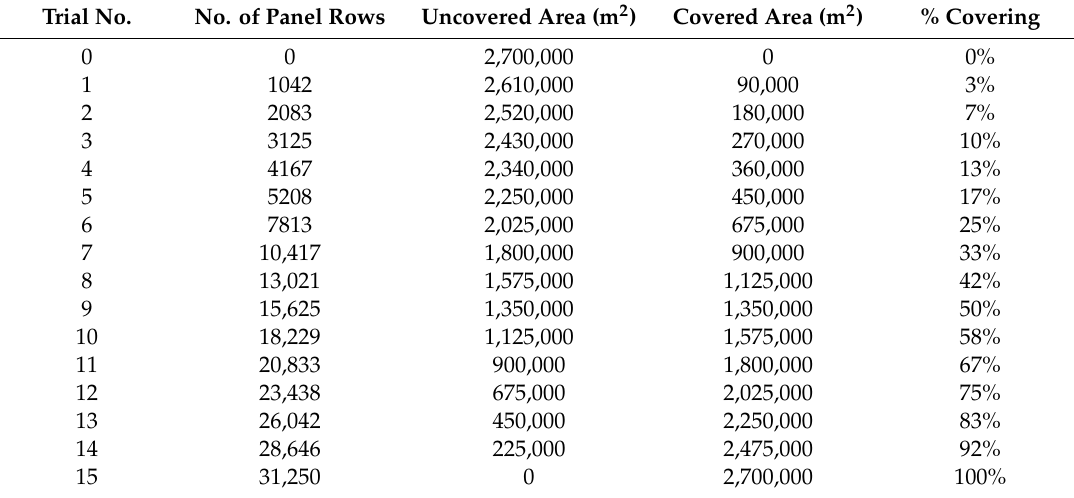
Figure 2. Proposed pontoon solar platform. Table 1. Number of panel rows and corresponding covered and uncovered area, and % covering of the